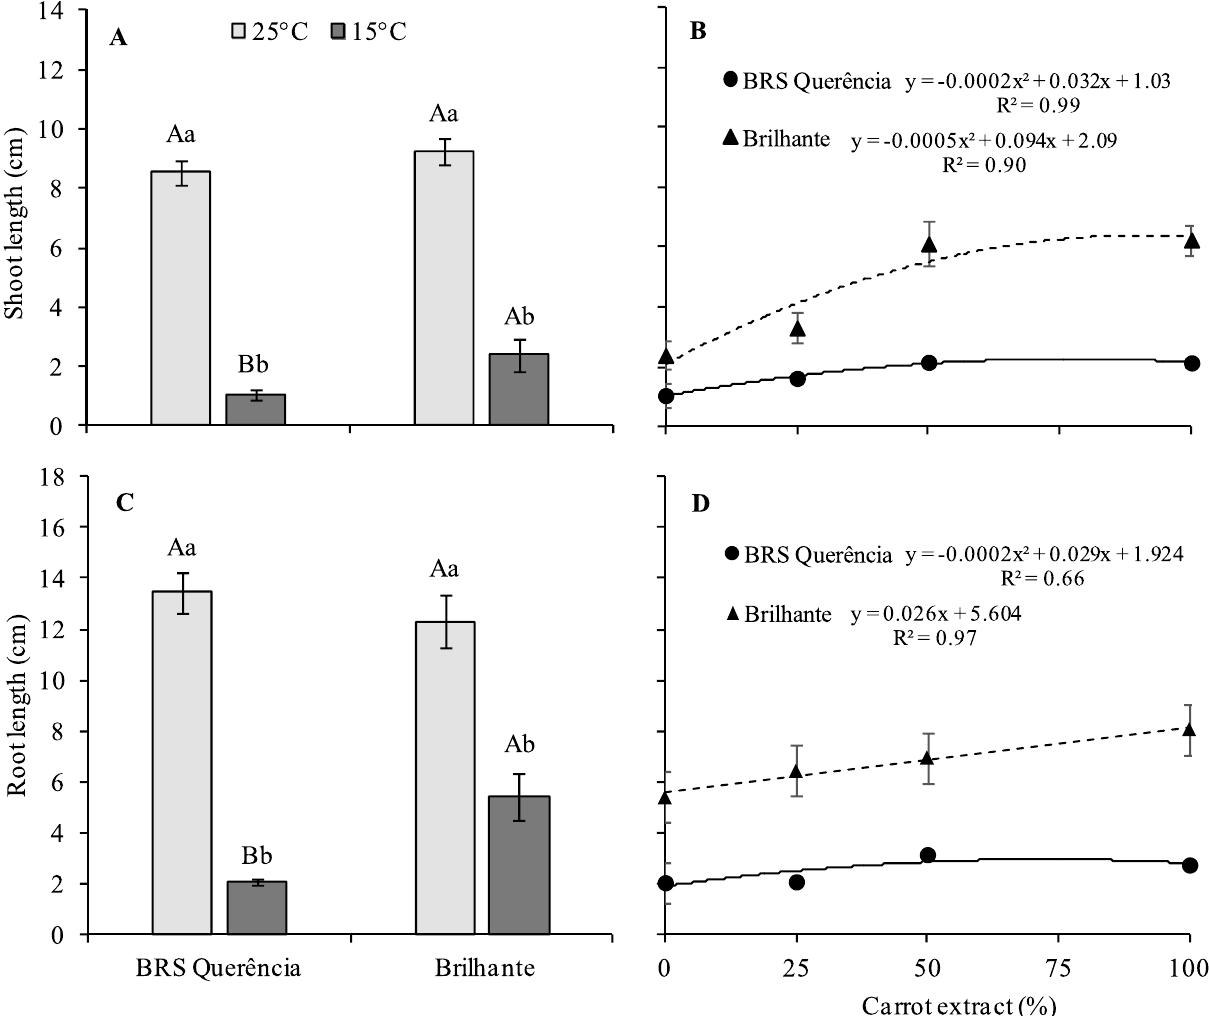
Figure 1. Shoot length of controls (A) , shoot length of treatments germinated at 15 °C (B) , root length of controls (C) , and root length of treatments germinated at 15 °C (D) of rice seedlings of cultivars BRS Querência (filled circle) and Brilhante (filled triangle). Means followed by the same letter, upper case in the comparison of the cultivars and lower case in temperatures, do not differ by Tukey’s test (P ≤ 0.05). Bars represent the standard error of the mean of four